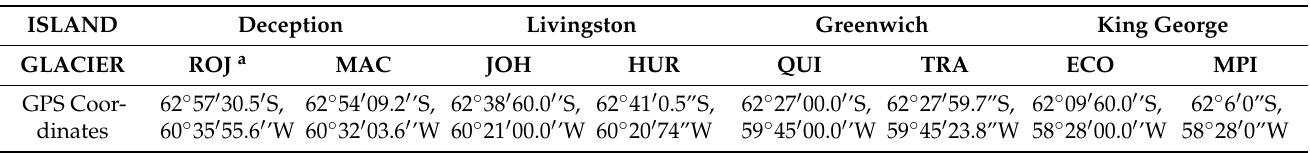
Table 1. Glacier